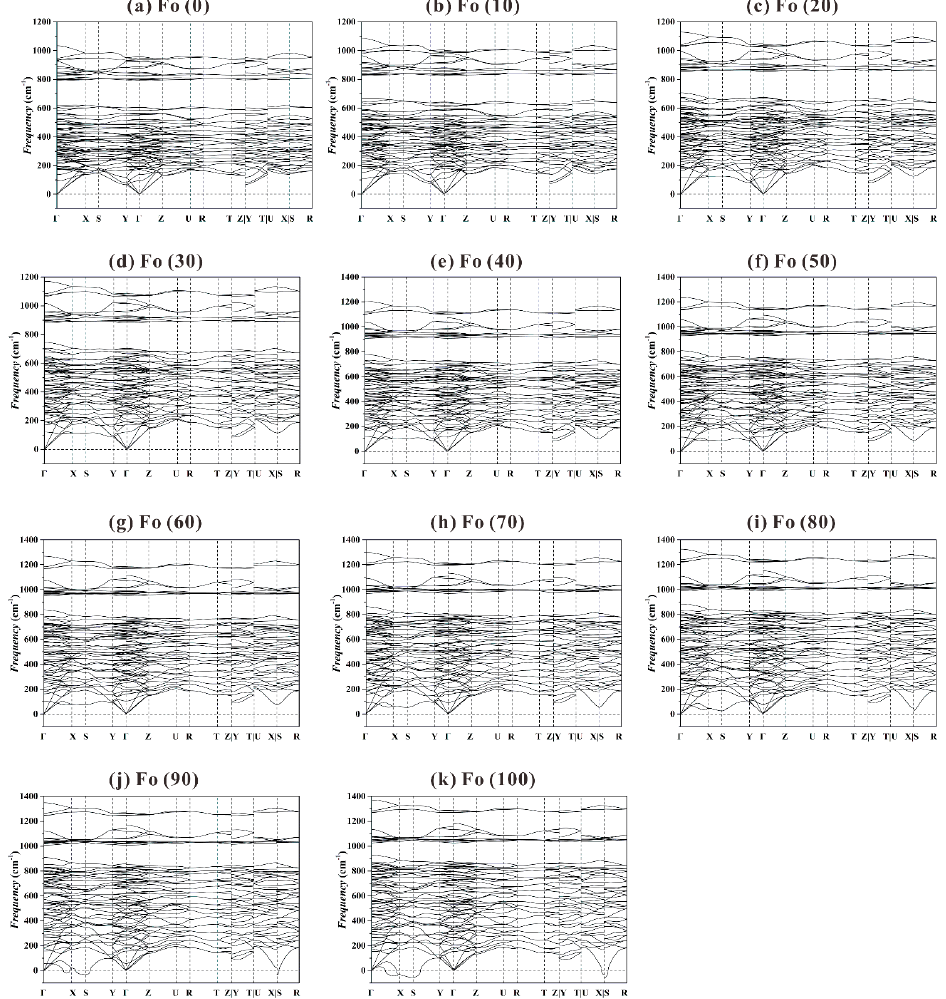
Figure 8. Calculated phonon dispersion curves for Fo from 0 to 100 GPa with a k -path Γ -X-S-Y- Γ -Z-U-R-T-Z|Y-T|U-X|S-R: ( a ) Fo at 0 GPa; ( b ) Fo at 10 GPa; ( c ) Fo at 20 GPa; ( d ) Fo at 30 GPa; ( e ) Fo at 40 GPa; ( f ) Fo at 50 GPa; ( g ) Fo at 60 GPa; ( h ) Fo at 70 GPa; ( i ) Fo at 80 GPa; ( j ) Fo at 90 GPa; ( k ) Fo at 100 GPa. The corresponding coordinates are Γ (0, 0, 0), X(0.5, 0, 0), S(0.5, 0.5, 0), Y(0, 0.5, 0), Z(0, 0, 0.5), U(0.5, 0, 0.5), R(0.5, 0.5, 0.5) and T(0, 0.5,